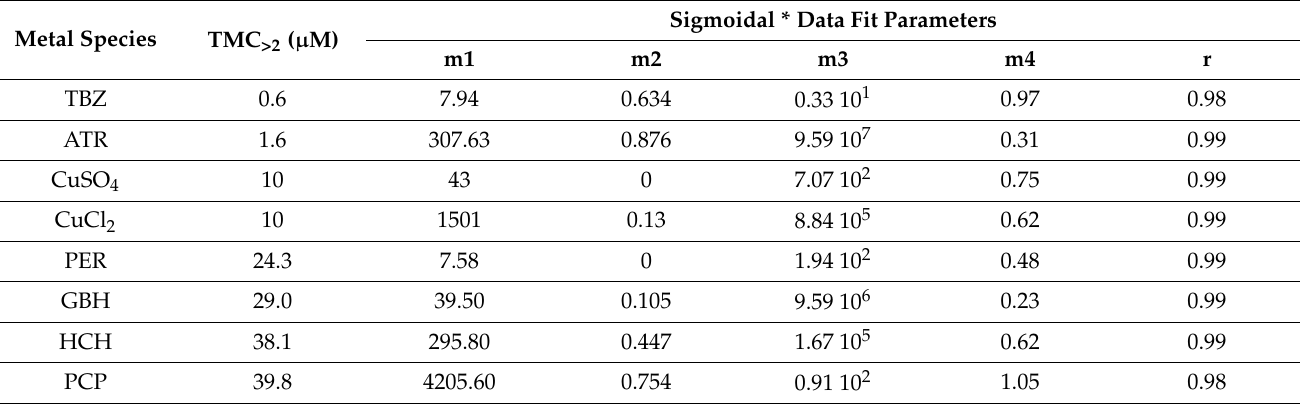
Table 2. Data fit parameters obtained from the pesticides and the metallic species